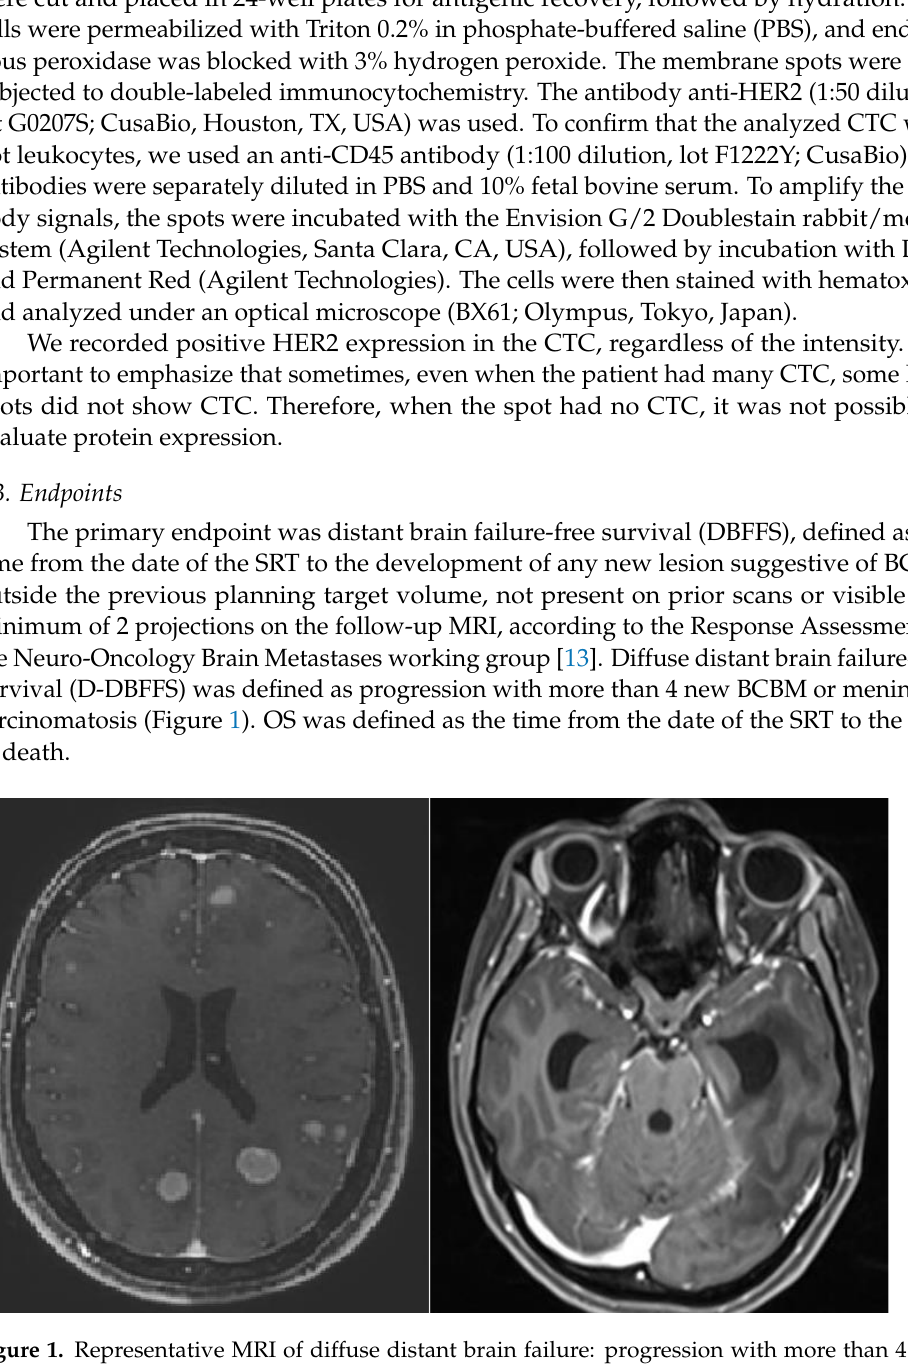
Figure 1. Representative MRI of diffuse distant brain failure: progression with more than 4 new lesions ( left ) and meningeal carcinomatosis ( right